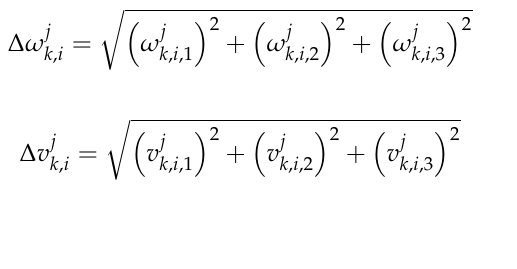
Figure 7. Simulation results using the standard deviations listed in Table 8. ( a ) Group 1; ( b ) Group 2; ( c ) Group 3.